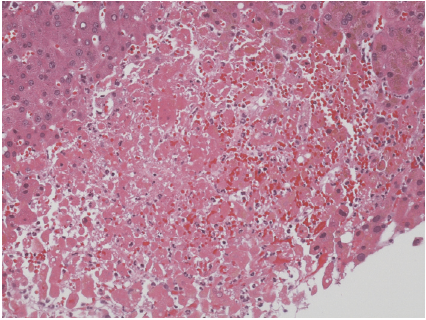
Figure 7: Larger foci of hepatocytes with frank necrosis.